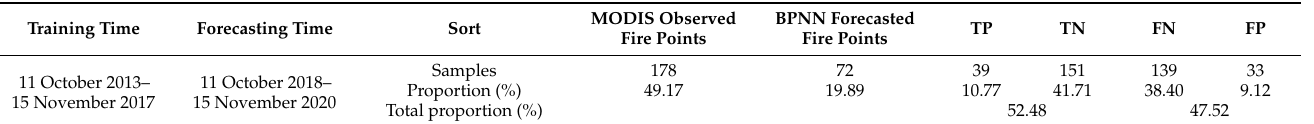
Table 4. Results of the BPNN in forecasting fire points over Northeastern China during 2018–2020 using the model developed in Section 3.1.2.